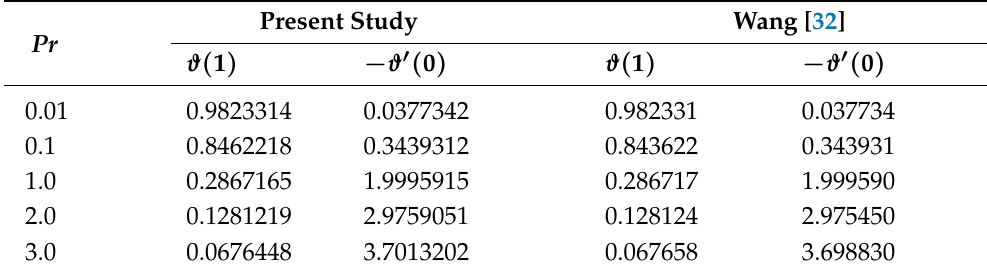
Table 5. Validation of numerical Results at S = 1.2 and G* =